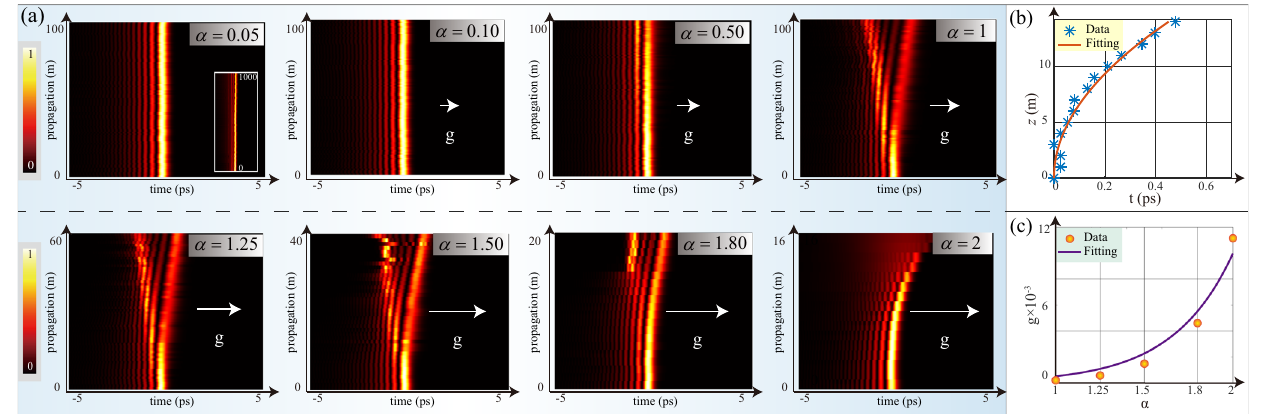
Fig. 3 | The propagation of self-accelerating Airy pulses in the optical Lévy waveguide.a showsthebeampropagationwithdifferentvaluesofLI α .Theinsetin the fi rst panel shows the long-range propagation distance, from z =0 to 1000m. White arrows designate effective gravity, whose strength is proportional to the lengthofthearrows.Ineachpanel,theverticalaxisrepresentstimeextendingfrom − 5 to 5ps; the horizontal axis represents the propagation distance, z ; the color provides a map of the normalized temporal intensity. b The data fi t for the